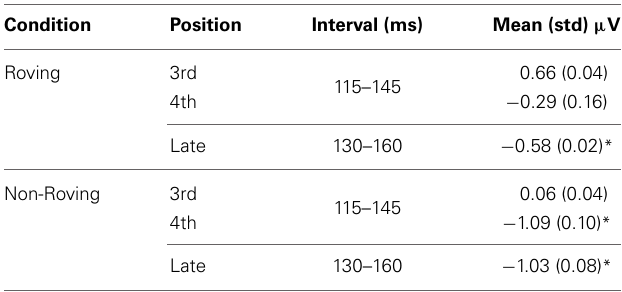
Table 2 | Mean amplitudes and intervals used to measure the MMN in each condition and position at the Fz